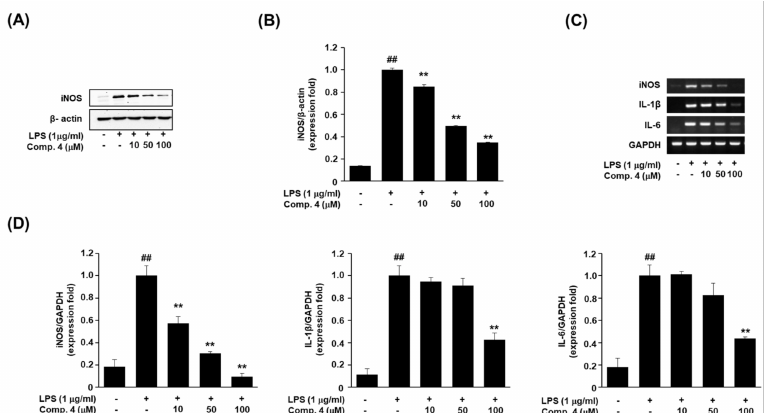
Figure 2. Effects of (1 R ,4 S ,6 S )-1,6-dihydroxy-2-menthene (compound 4 ) on iNOS protein and pro- inflammatory cytokine mRNA expression in LPS-stimulated RAW264.7 cells. RAW264.7 cells were pretreated with different concentrations (10, 50, 100 µ M) of compound 4 for 1 h, and then stimulated with 1 µ g/mL LPS for 24 h. ( A , B ) Western blot analysis of iNOS expression in cells treated with compound 4 (10, 50, 100 µ M). β -Actin was used as a loading control. ( C , D ) Levels of iNOS, IL- 1 β , and IL-6 mRNAs were determined via RT-PCR. RT-PCR data results were expressed as the fold of changes of the target gene (iNOS, IL-1 β , and IL-6) and normalized to the GAPDH. Values represent the mean ± SD of three independent experiments. Statistical significance is indicated ( ## p < 0.01 compared to the untreated control/LPS (-), while ** p < 0.01, compared to LPS-treated cells group/LPS